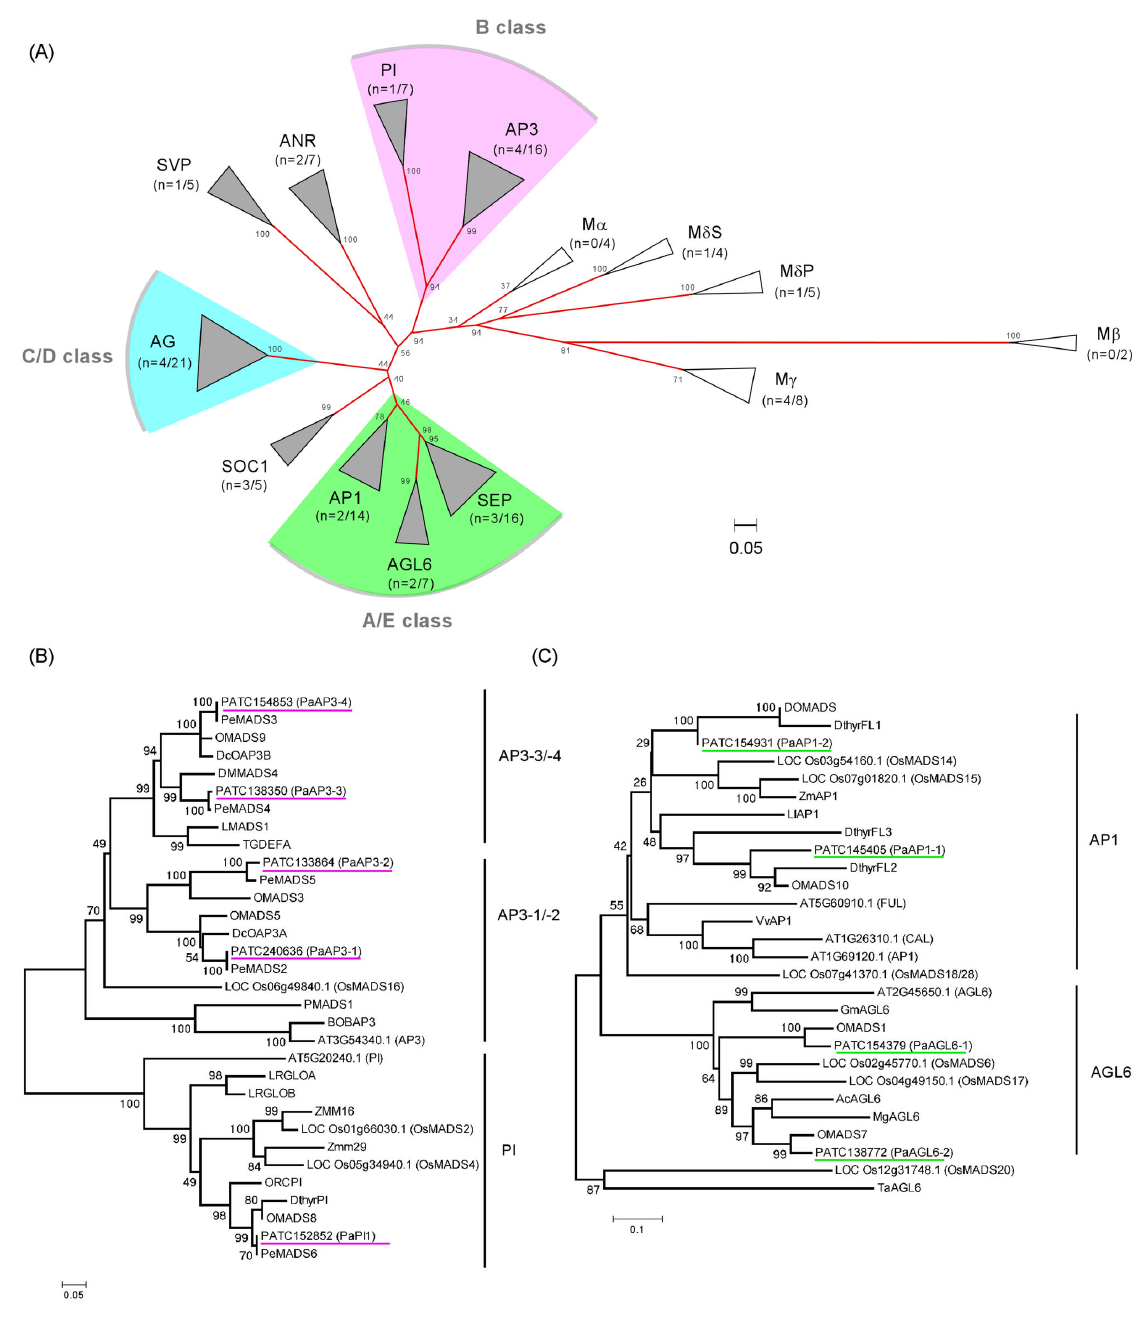
Figure 2. Phylogenetic analysis of the MADS box gene family. (A) A simplified view of groupings. MIKC-type MADS box genes including APETALA3 (AP3), PISTILLATA (PI), ANTHOCYANIDIN REDUCTASE (ANR), SHORT VEGETATIVE PHASE (SVP), AGAMOUS (AG), SUPPRESOR OF OVEREXPRESSION OF CONSTANS1 (SOC1), APETALA1 (AP1), AGAMOUS-LIKE6 (AGL6) and SEPALLATA (SEP) are indicated by unfilled triangles. M-type MADS box genes including Mα , Mβ , M γ and M δ(S type and P type) are indicated by unfilled triangles. The A/E class of MADS box gene comprises AP1 , AGL6 and SEP genes; the C/D class comprises of AG genes and the B class comprises of PI and AP3 genes. The numbers in the parenthesis indicate the number of MADS box genes identified in P . aphrodite versus the total number of genes. Altogether, 121 MADS box genes were used in this phylogenetic analysis: 30 from Arabidopsis , 28 from rice, and 63 from orchid species (among which, 28 were identified in P . aphrodite ). (B) Detailed phylogenetic analysis of class B genes, AP3 and PI . (C) Detailed phylogenetic analysis of class A genes AP1 and AGL6 . Accession number and gene information are listed in Table S4 in File S1. doi: 10.1371/journal.pone.0080462.g002 PLOS ONE |